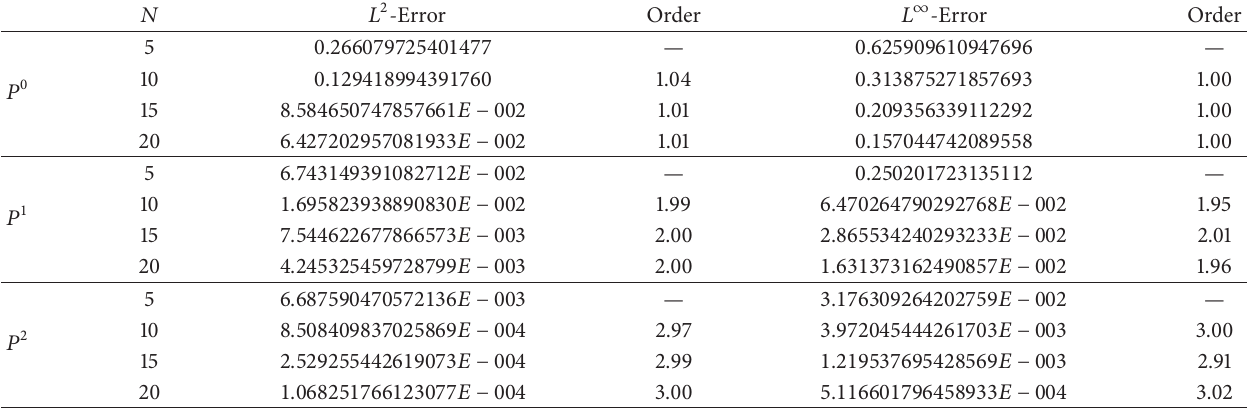
Table 1: Spatial accuracy test for the fractional order equation with the forcing term (42). 𝛼 = 0.1 , 𝑀 = 10 4 , 𝑇 = 1 . 𝑁 𝐿 2 -Error Order 𝐿 ∞ -Error Order